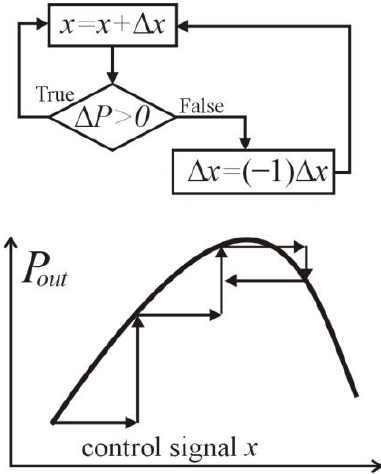
Figure 6. Hill-climb search algorithm.